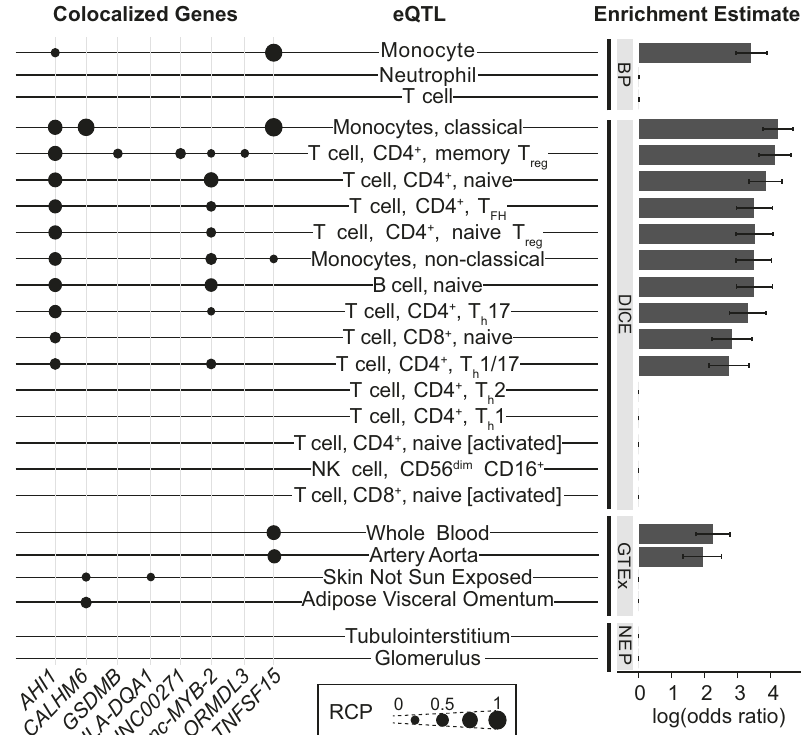
Fig. 3 | Colocalization of SSNS GWAS and eQTL datasets. Each eQTL dataset is labeled with colocalized loci (left) and enrichment estimates (right). The source of each eQTL dataset is labeled on vertical gray bars. BP BLUEPRINT, NEP NEPTUNE. Geneswith regionalcolocalization probability (RCP)>0.2in at leastonetissue/cell are included. pSSNS GWAS loci that colocalized with tissue/cell-type eQTLs are indicated by black dots, with larger dots indicating higher RCP. GTEx tissues without associations are excluded from this fi gure (see Supp. Fig. 7). Enrichment